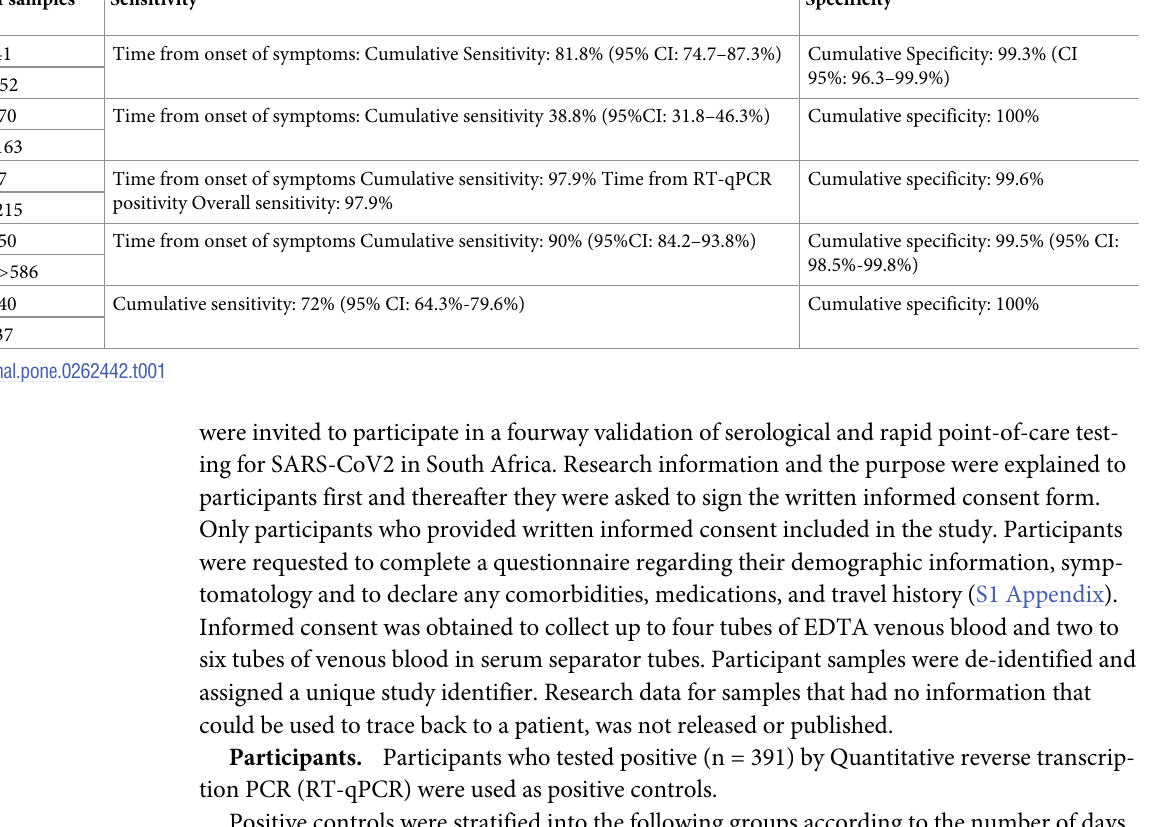
Table 1. Cumulative review of Abbott Architect SARS IgG validation